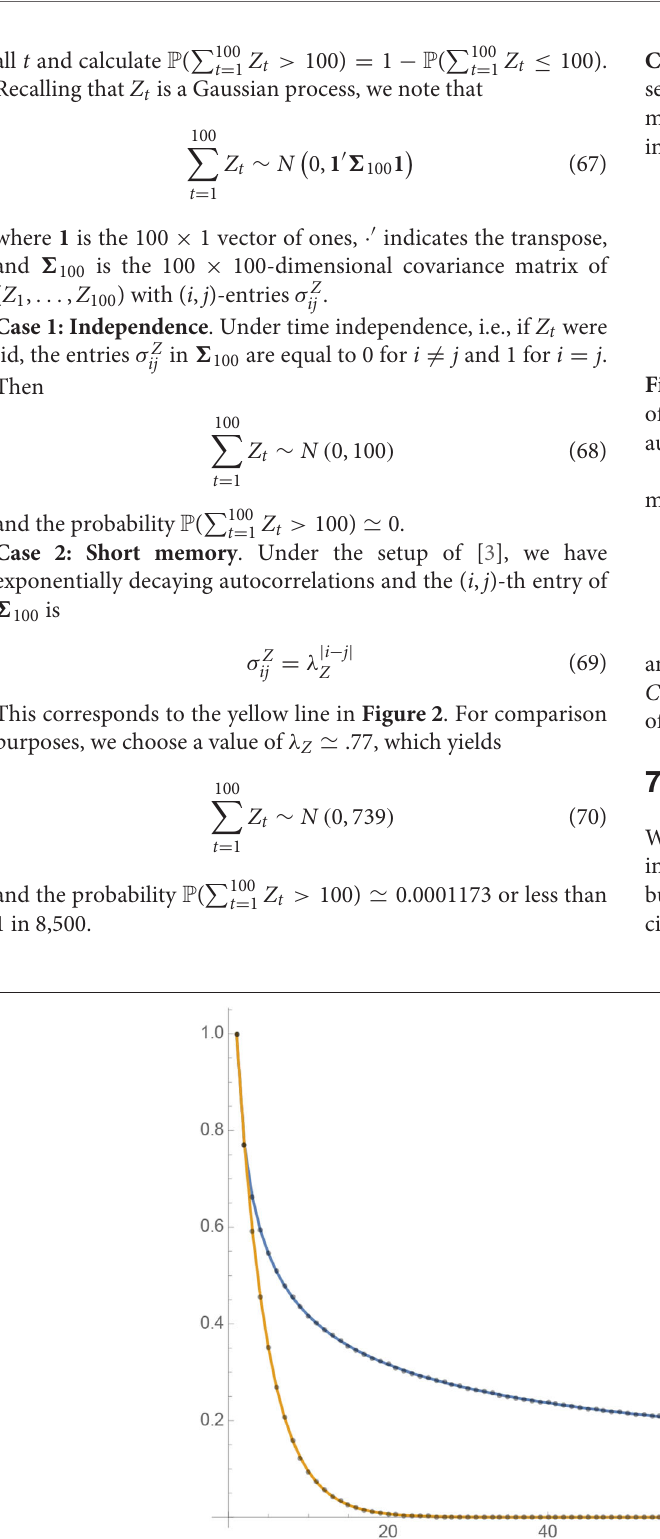
Frontiers in Physics |